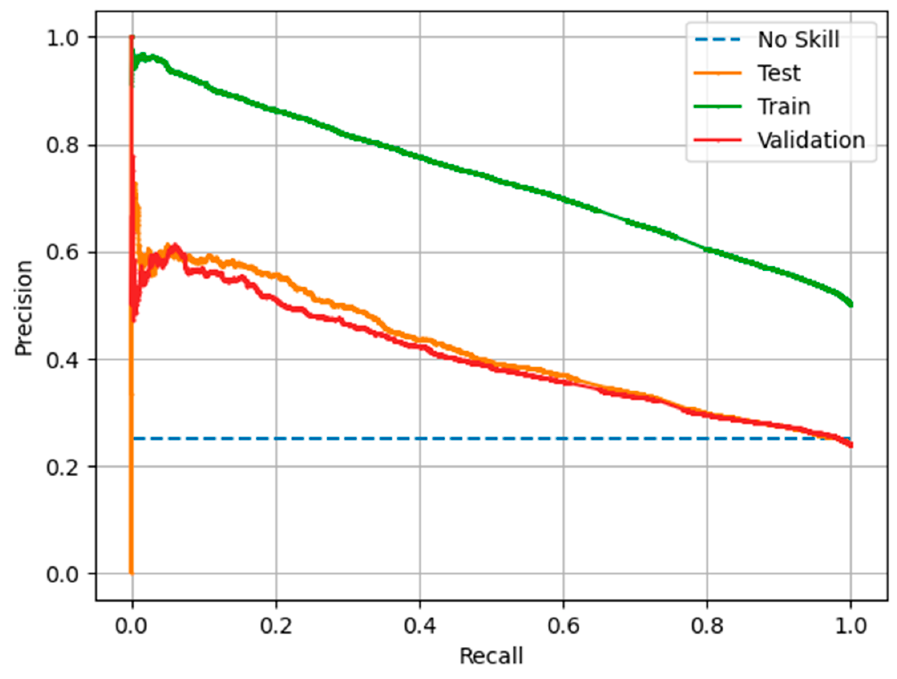
Figure 10. PR-Curve—Results with Temperature.